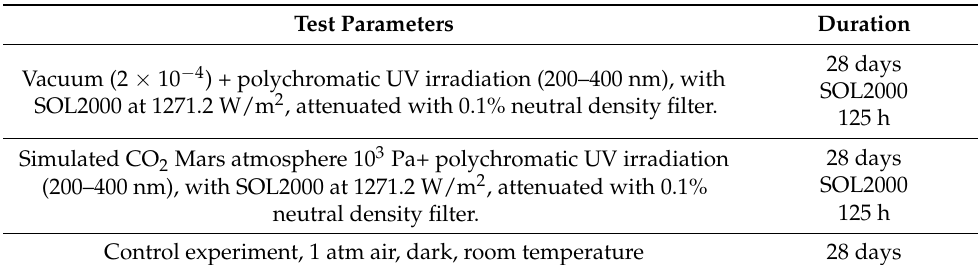
Table 1. Exposure conditions during the Scientific Verification Tests (SVTs). Test Parameters